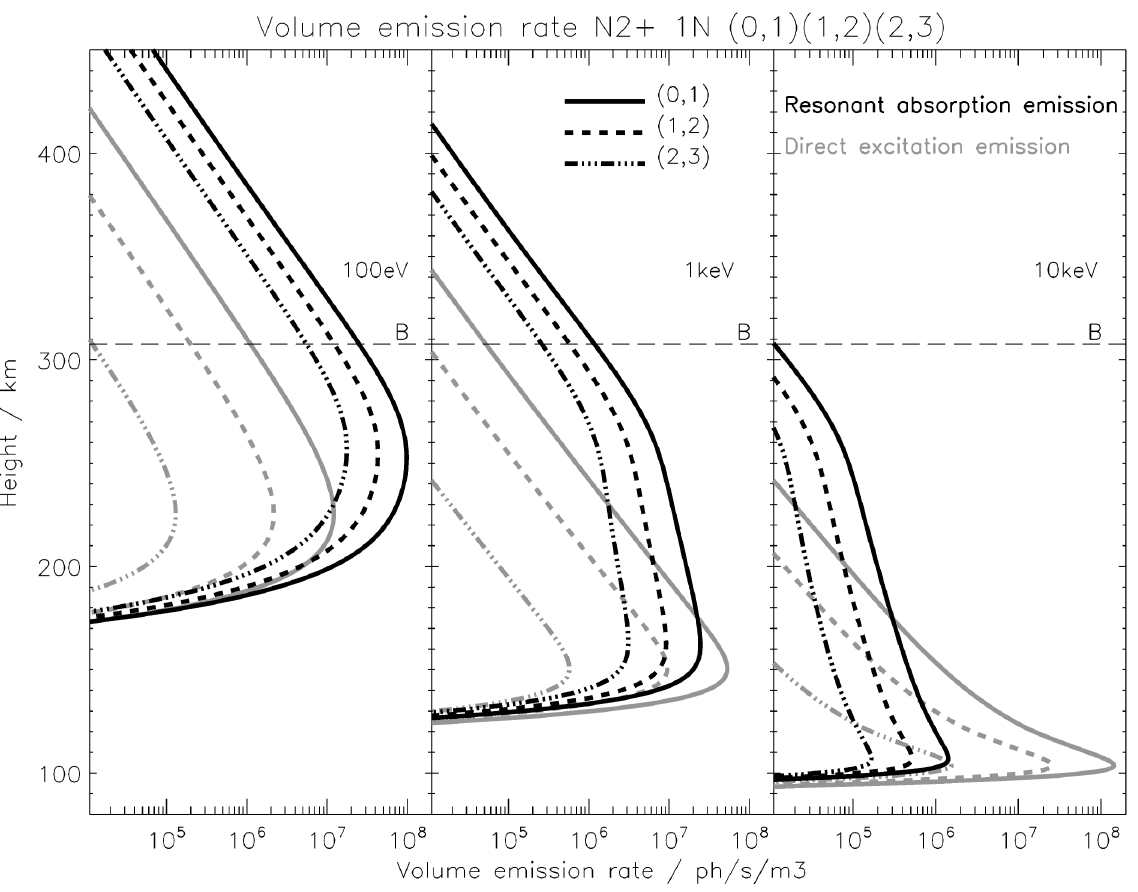
Fig. 6. Synthetic volume emission rates of N + (0,1) (solid),(1,2) (dashed) and (2,3) (dot-dash) corresponding to input energies of 100eV, 2 1keV and 10keV for 30s. Emission rates from direct excitation are in grey and resonance scattered emissions are in black. The steady state boundary for this condition is drawn at height